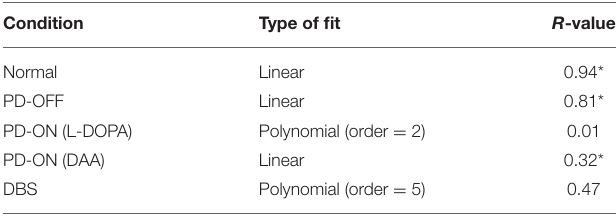
TABLE 3 | Table explains the goodness of fit for the simulation results obtained from testing accuracies and DRE for all the conditions.